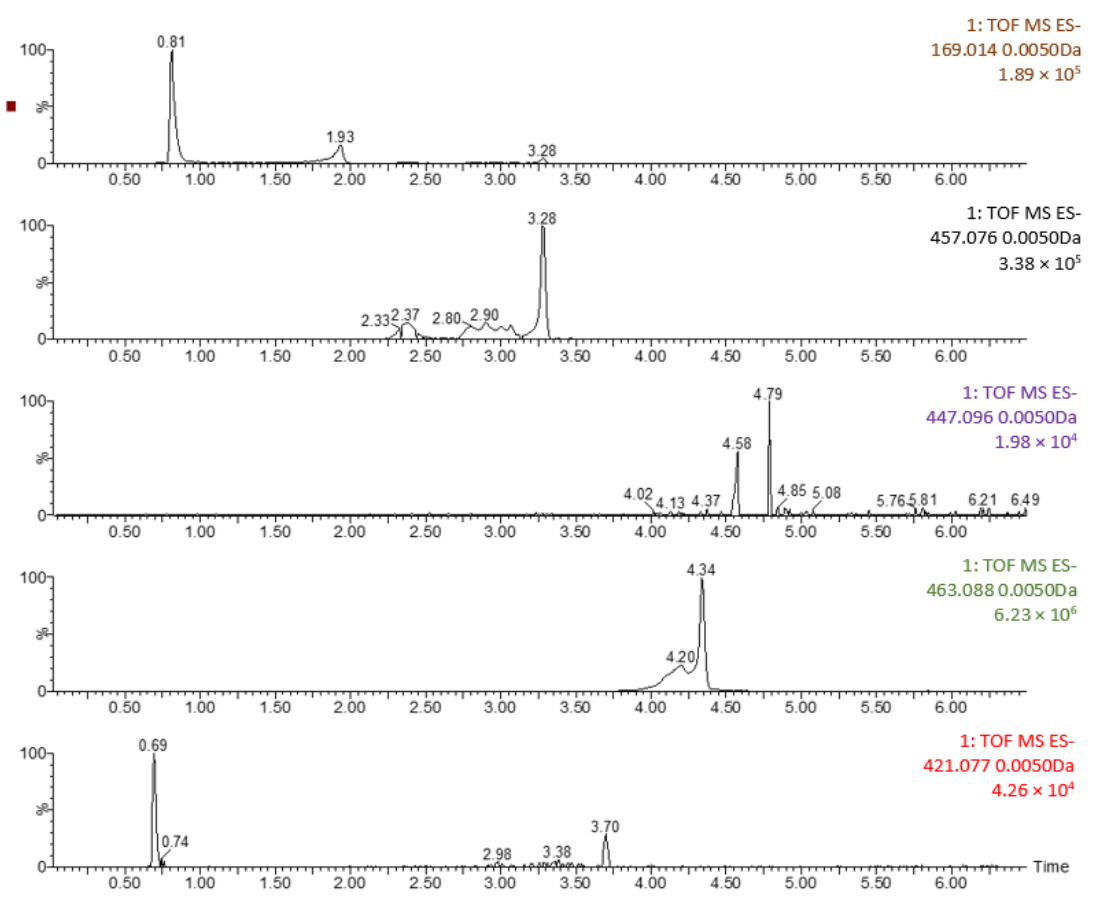
Figure 6. Mass spectra for the identification of compounds in run 8. Table 6. Chemical composition of myrtle leaf extract and precipitates.